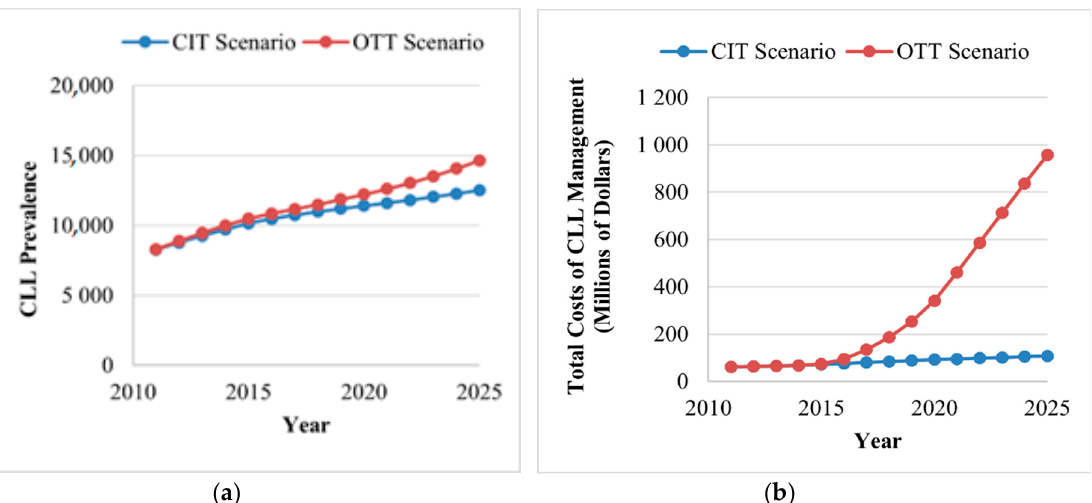
Figure 3. Trends in disease and cost a burden of CLL for the CIT and the OTT scenarios. ( A ) The annual prevalence of CLL (excluding patients in the watchful waiting health state) under the CIT and OTT scenarios. The use of OTT is projected to increase the number of patients living with CLL from 8301 in 2011 to 14,654 by 2025 (1.8-fold increase). ( B ) The total costs of CLL management per year for the CIT and OTT scenarios. The use of OTT is projected to increase the annual costs from $60.8 million in 2011 to $957.5 million in 2015 (15.7-fold increase), which is mainly driven by the increased number of patients with CLL, high drug costs and the increased duration of treatment. CIT, chemoimmunotherapy; CLL, chronic lymphocytic leukemia; OTT, oral targeted therapy. a All costs are shown in 2019 Canadian dollars.